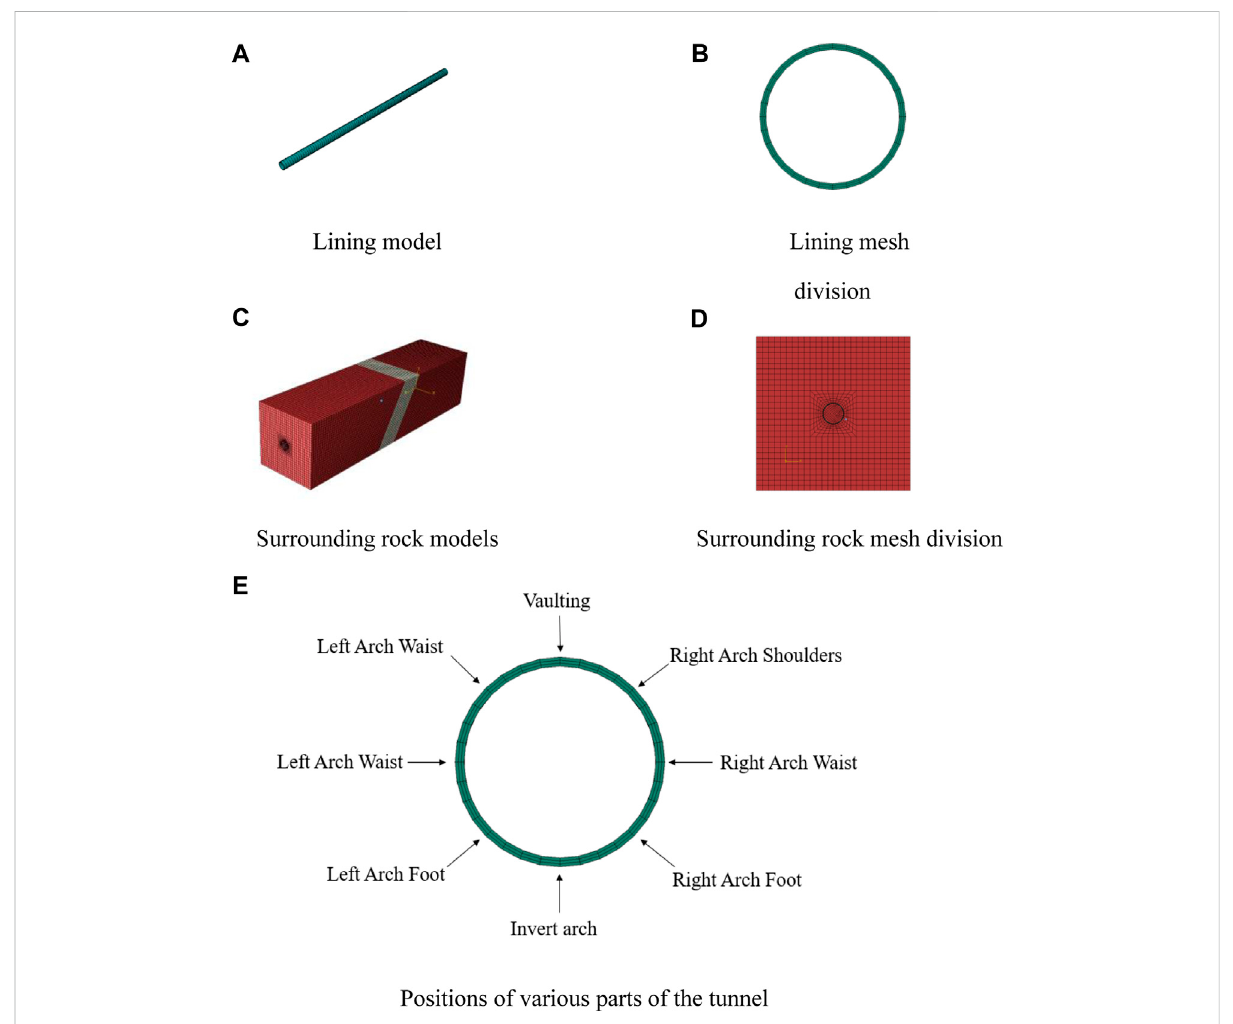
FIGURE 3 Modeling model of tunnel surrounding rock. (A) FEM Lining model; (B) FEM Lining mesh; (C) Surrounding rock models; (D) Surrounding rock mesh division.